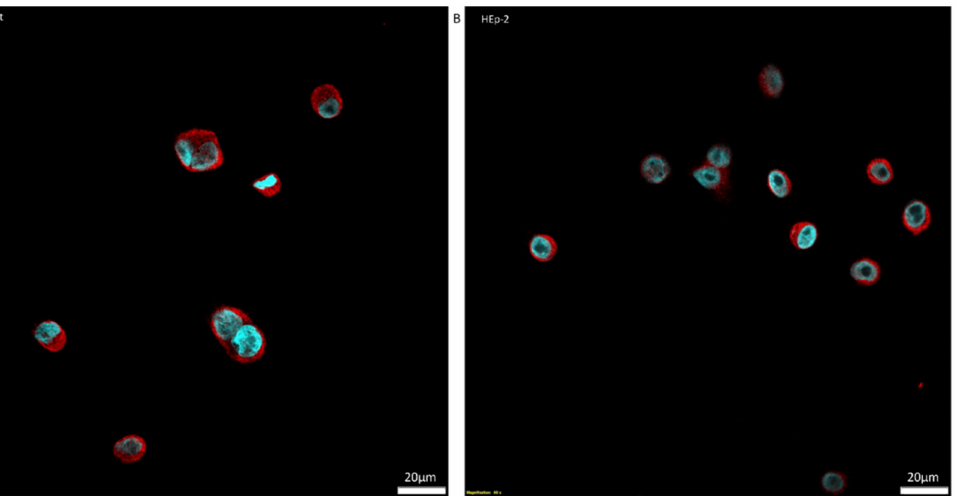
Figure 6. Localization of irisin (red color) around the nucleus (blue color) expression in cells’ cy- toplasm detected by immunofluorescence reaction (IF) in Normal Human Keratinocytes (HaCat) ( A ) and Larynx Epidermoid Carcinoma 2 (HEp-2) ( B ) (magnifications × 600, scale bar-20 µ m (lower right